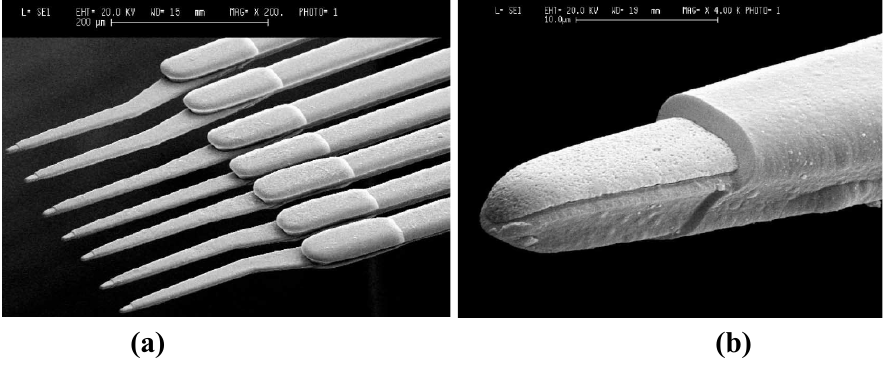
Figure 3. SEM Micrographs of: (a) Seven array microelectrode tip regions. (b) The Parylene electrode in a Parylene window on the tip. Reprinted from [64], with permission from Elsevier.